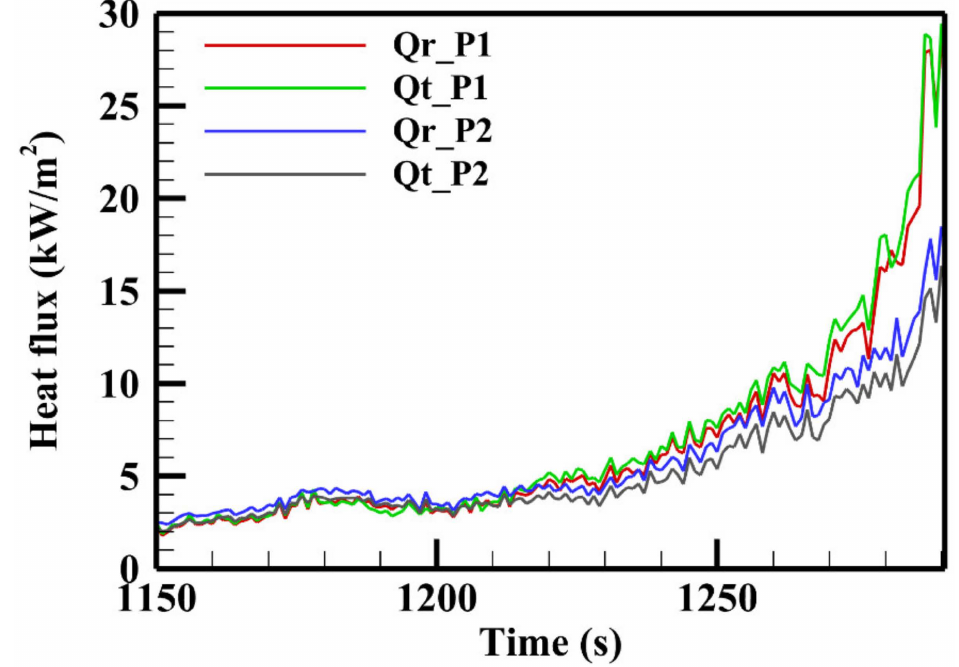
Figure 12. Time evolution of the radiative (Qr) and total (Qt) heat fluxes obtained experimentally at different target positions P1 and P2 during March (2022)